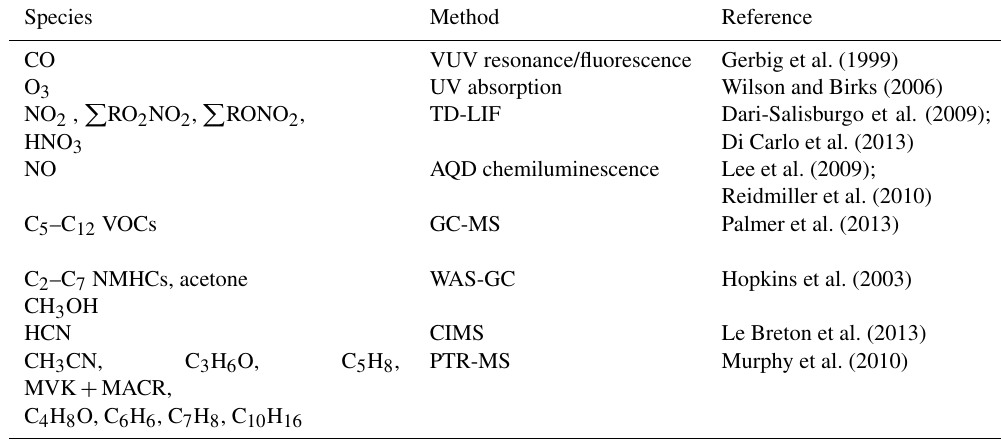
Table 1. List of FAAM BAe-146 instrumental payload and observed compounds used in the analysis in this paper. A description of the FAAM BAe-146 instrumental payload, with accuracy and detection limit, is reported in Table 2 of Palmer et al. (2013).